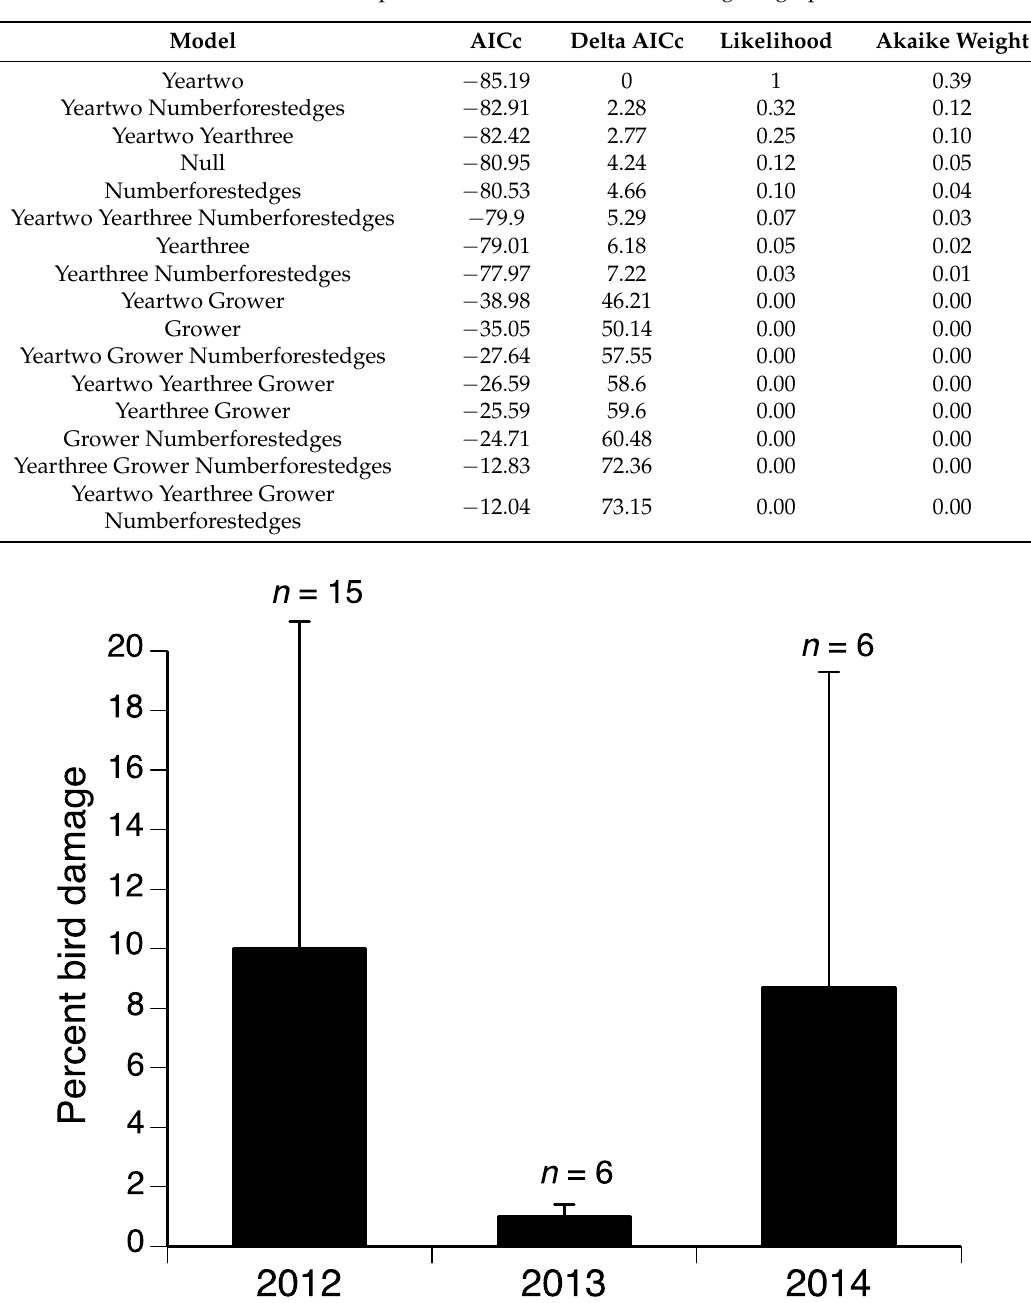
Figure 2. Percent bird damage in Michigan Pinot noir vineyards. Error bars are standard deviations. n = number of blocks sampled.